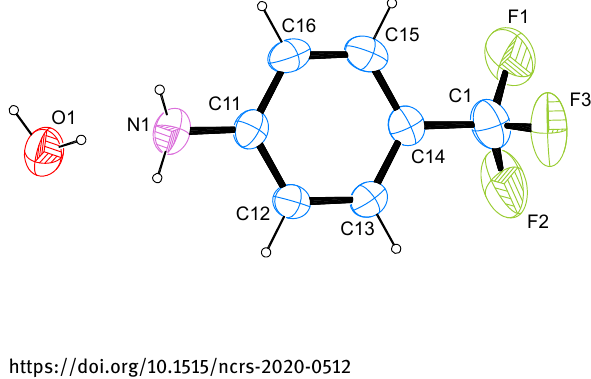
Table  : Data collection and handling.